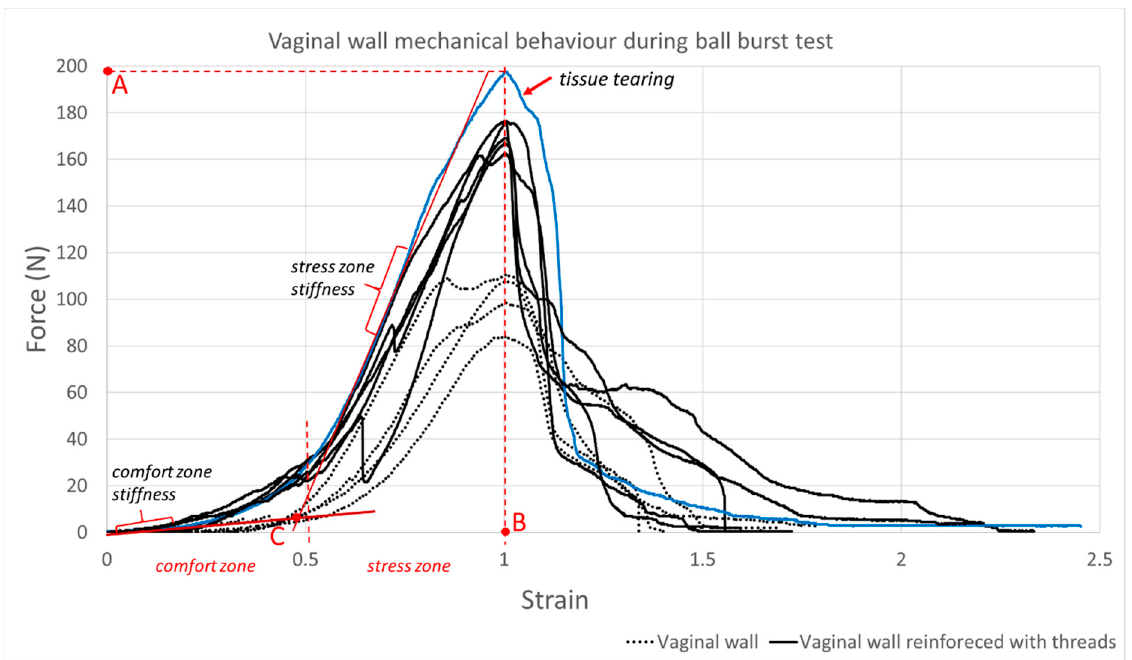
Figure 6. Mechanical behavior of the sow vaginal wall during ball burst test with and without cog threads. A blue colored curve was used as an example to clarify studied tissues characteristics: comfort and stress zone stiffness; A—ultimate load, B—the maximum change in length at ultimate force; C—comfort zone length.